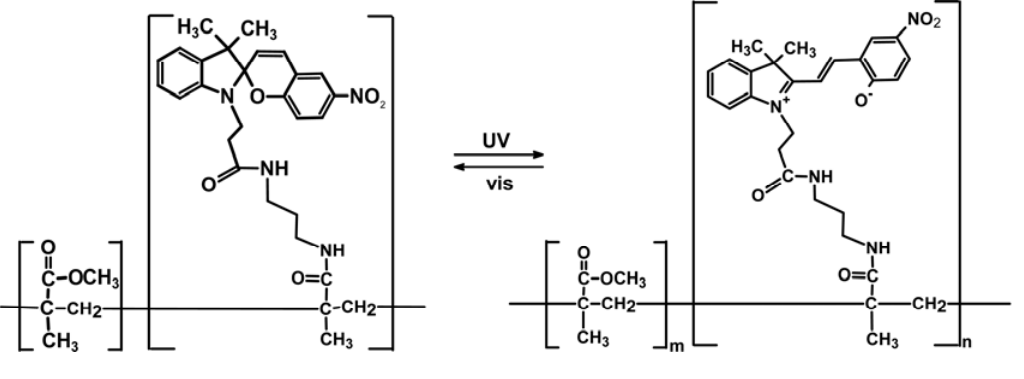
Figure 35. Photo-switching in